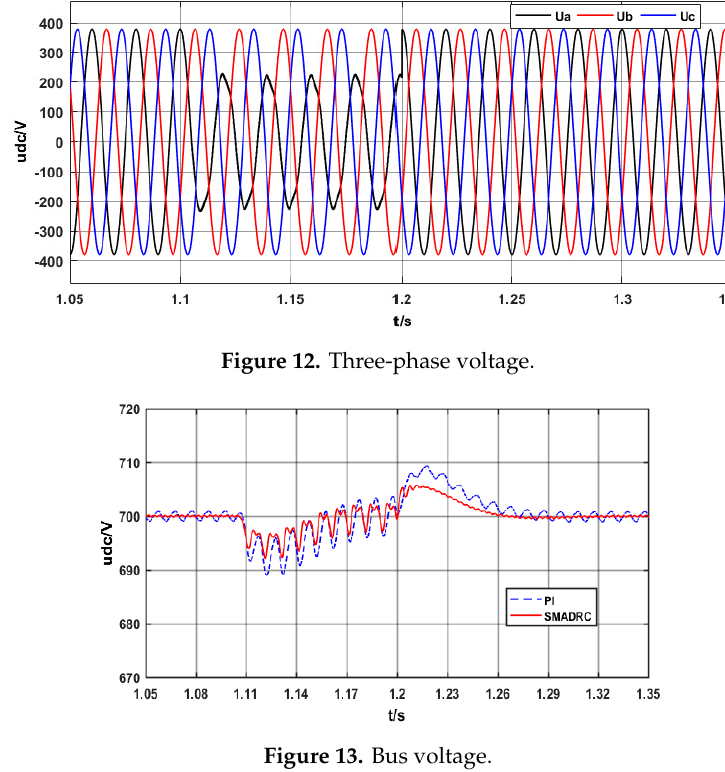
Figure 13. Bus voltage.